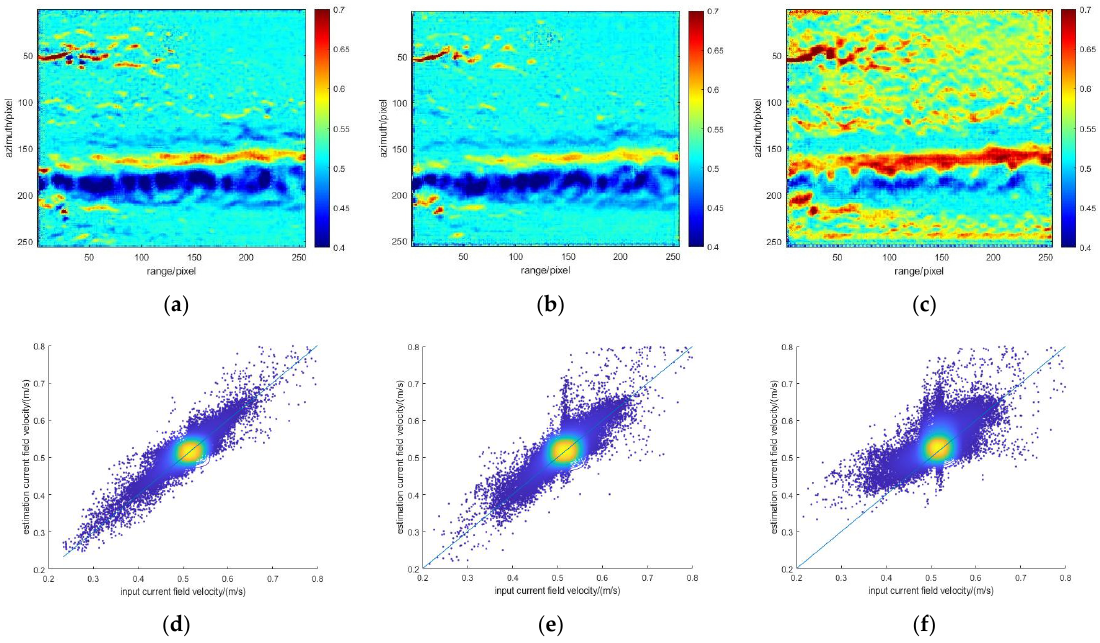
Figure 15. The estimation velocity of ocean surface currents under the different wind velocities from ( a – c ): ( a ) 5 m/s, ( b ) 10 m/s, and ( c ) 15 m/s. The scatter density map between the estimation velocity of ocean surface currents and the control group velocity of the input ocean surface currents under the different wind velocities ( d – f ): ( d ) 5 m/s, ( e ) 10 m/s, and ( f ) 15 m/s. Table 9. Statistics of the estimation results under different wind